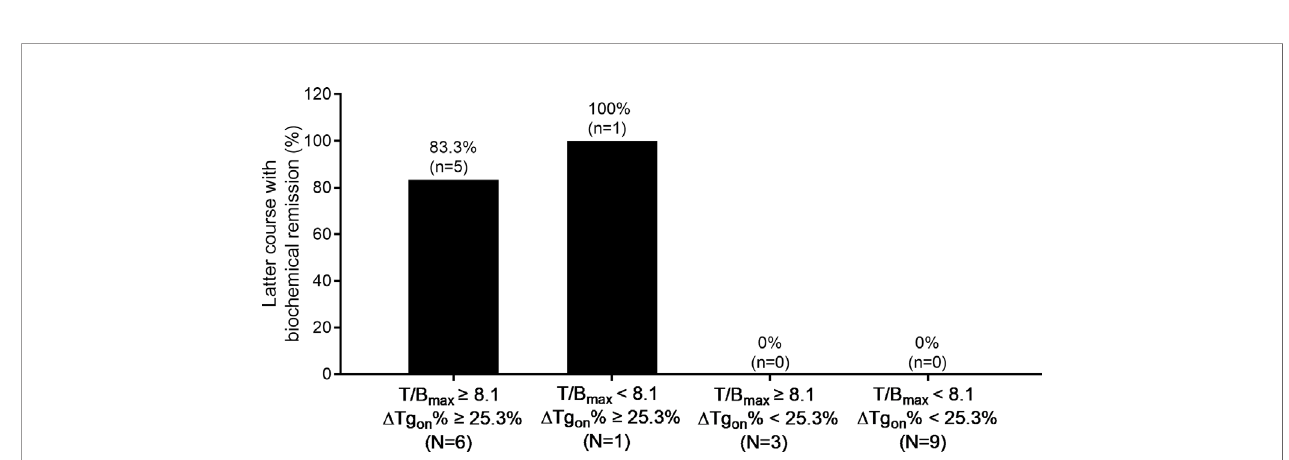
FIGURE 5 | Distribution of biochemical remission in 19 paired latter courses of RT in patients with 131 I-nonavid metastases concomitant with 131 I-avid metastases with regard to the results of T/B max and D Tg on % obtained from the former courses. RT, radioiodine treatment; T/B max , maximum target-to-background ratio; Tg on , thyroid stimulating hormone-suppressed thyroglobulin; D Tg on %, change rate of Tg on